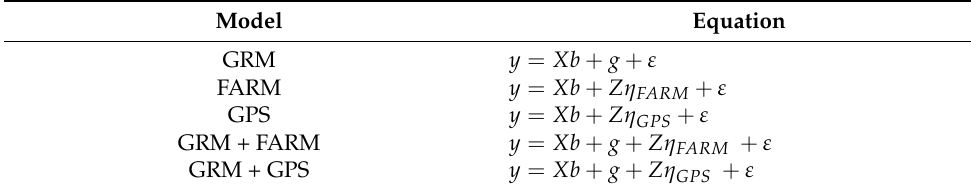
Table 3. Models used for